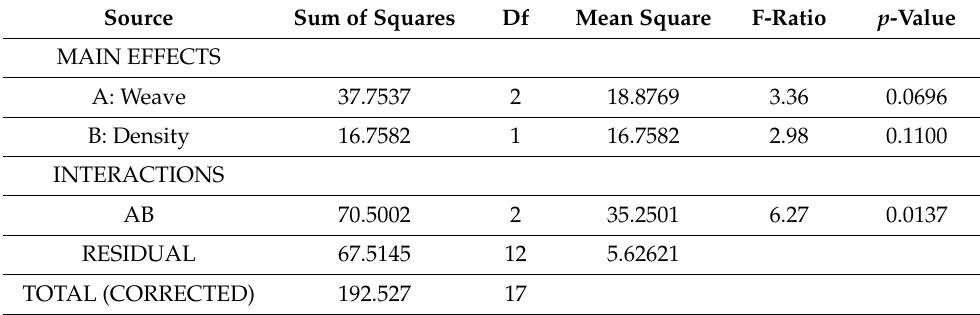
Table 9. Impact of weave and density on the adhesion force for double fabrics for z2.